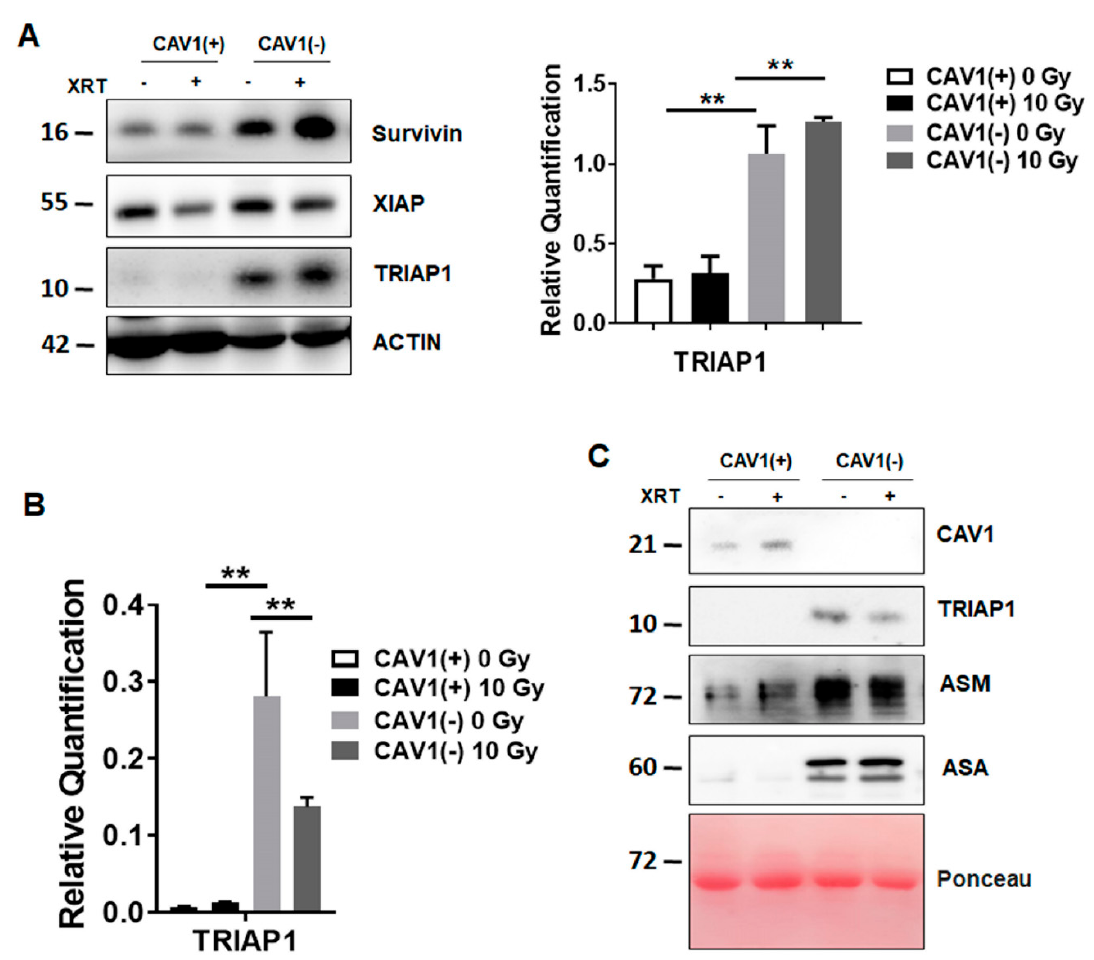
Figure 1. Radiation-resistant Caveolin-1 (CAV1)-silenced fibroblasts differentially express and secrete the apoptosis inhibiting protein TP53-regulated inhibitor of apoptosis 1 (TRIAP1).